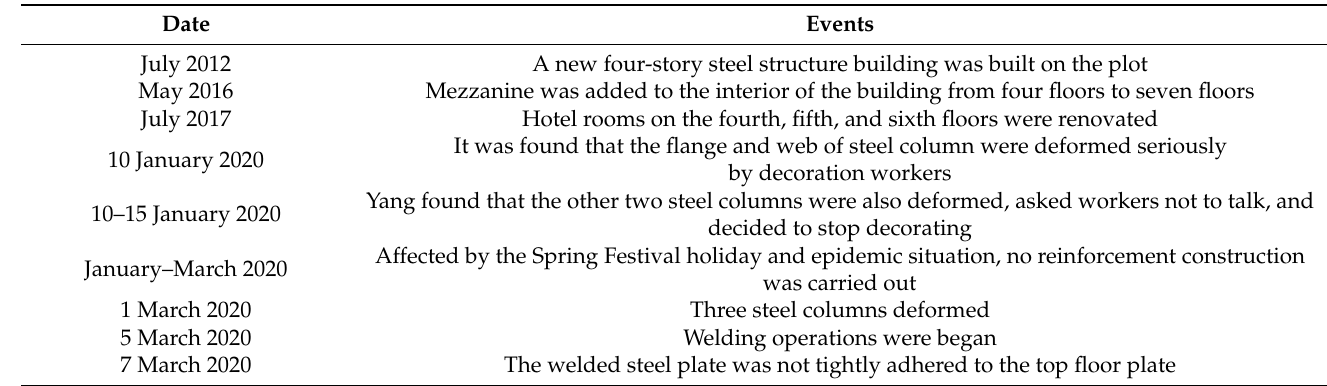
Table 1. The proximal events leading to the hotel collapse